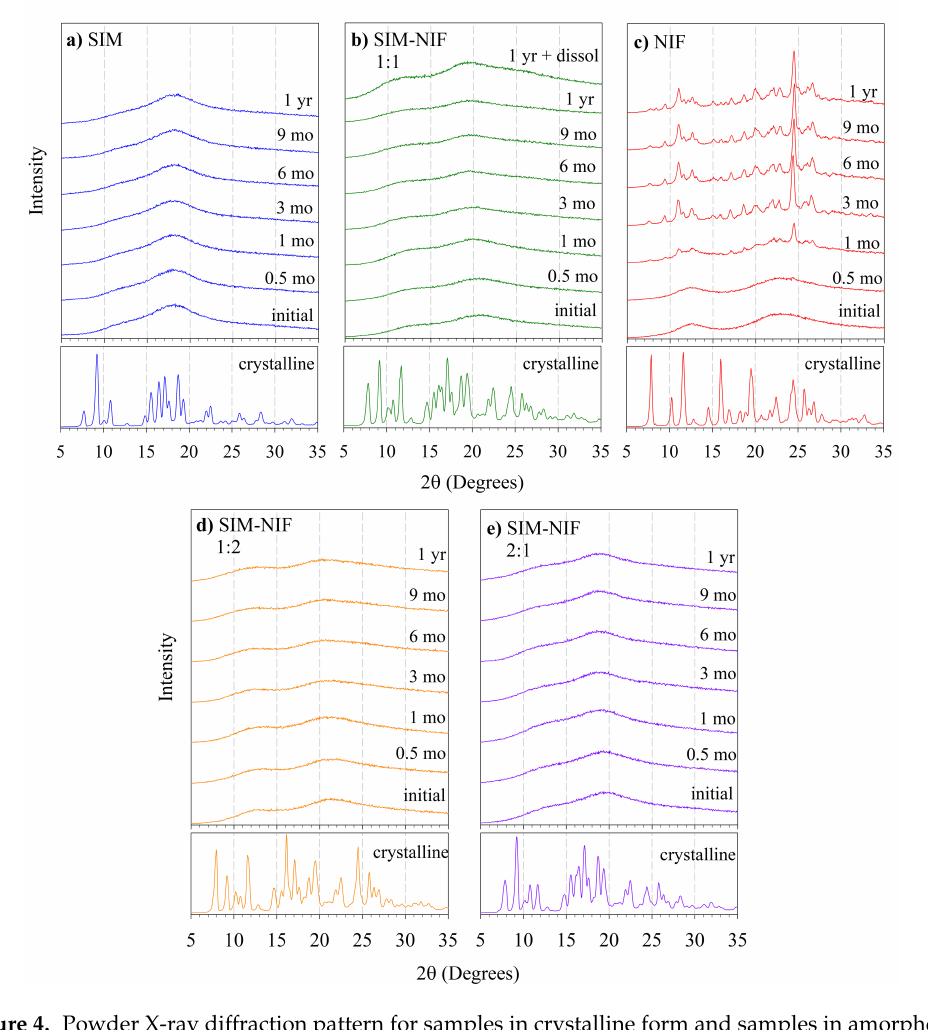
Figure 4. Powder X-ray diffraction pattern for samples in crystalline form and samples in amorphous form studied as a function of storage time, measured by X-ray diffraction (XRD). ( a ) Pure SIM ( b ) SIM-NIF 1:1 ( c ) Pure NIF. ( d ) SIM-NIF 1:2 ( e ) SIM-NIF 2:1 Also, the XRD pattern of a remainder of a sample subjected to a dissolution process is shown in ( b